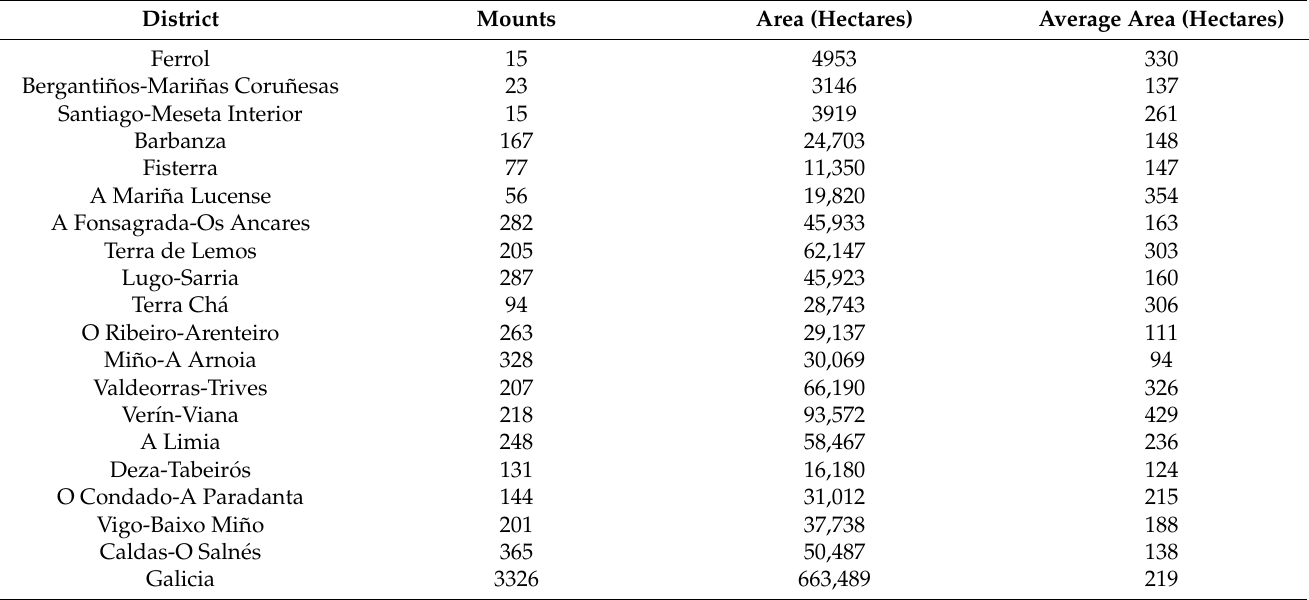
Table 1. Number and area of Communal Forest by district (2019).